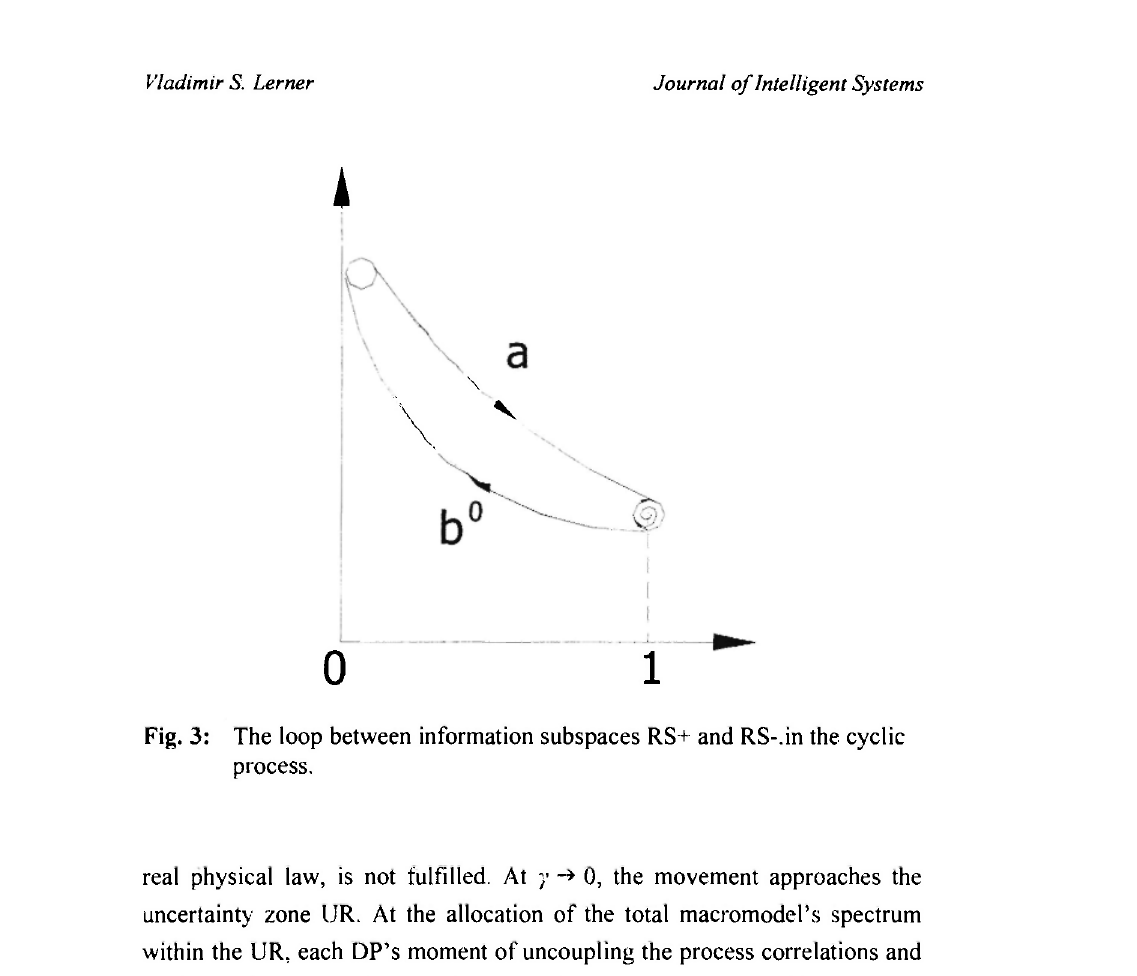
real physical law, is not fulfilled. At γ -* 0, the movement approaches the uncertainty zone UR. At the allocation of the total macromodel's spectrum within the UR, each DP's moment of uncoupling the process correlations and the intervals between them, including the last one. tum to zero with a maximal uncertainty of Α I.